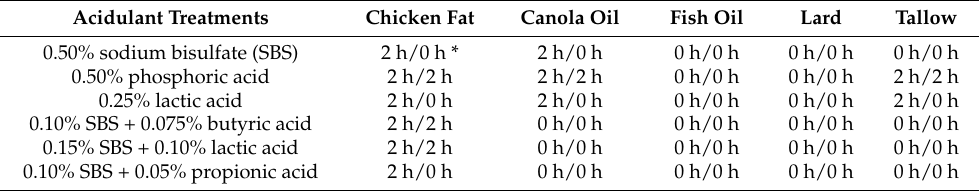
Table 1. Time to non-detection of Salmonella in acidulants-treated fat or oil system.